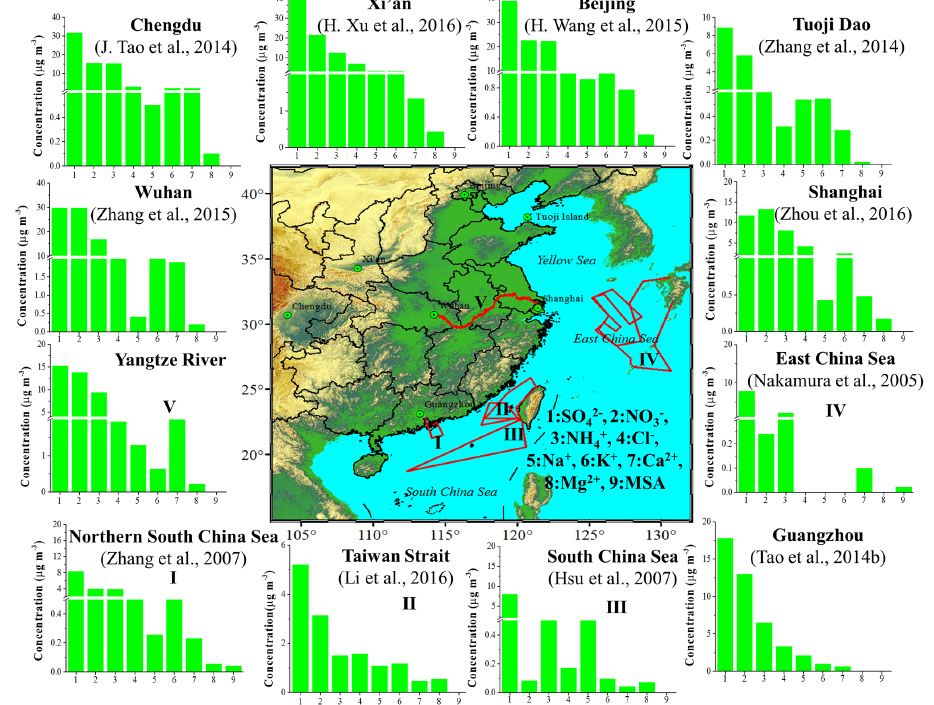
Figure 4. Comparisons of major ionic species during the YRC with other regions, including Beijing, Xi’an, Chengdu, Wuhan, Guangzhou, Shanghai, northern South China Sea, Taiwan Strait, South China Sea, East China Sea, and Tuoji Dao. The red lines mark the sample routes in different